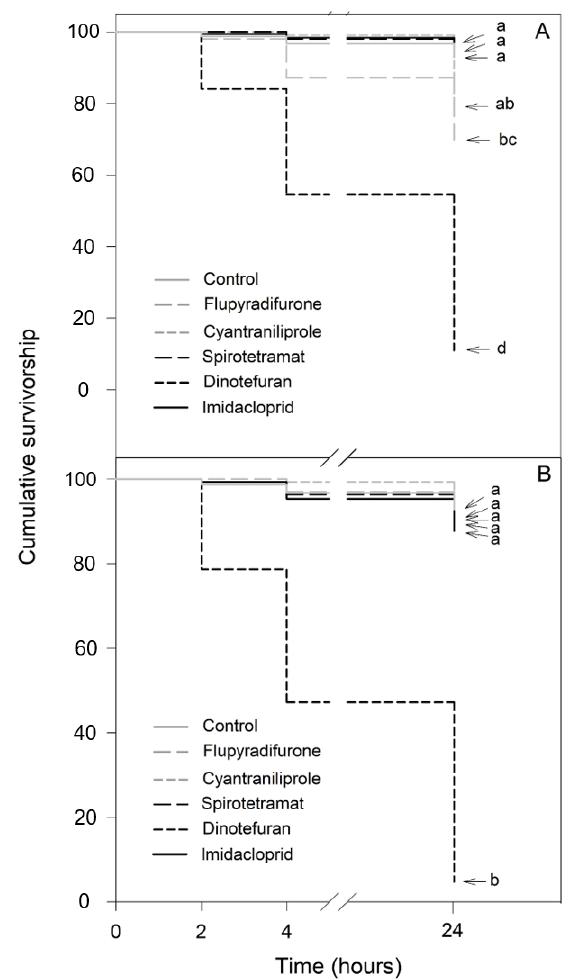
Figure 3. Kaplan–Meier survivorship curves of stingless bees orally exposed to 100-fold diluted commercial formulation of the selected insecticides: dinotefuran, 6 mg L −1 ; imidacloprid, 7 mg L −1 ; flupyradifurone, 6.8 mg L −1 ; spirotetramat, 3 mg L −1 ; and cyantraniliprole, 2 mg L −1 . The figure displays Nannotrigona perilampoides ( A ) and Frieseomelitta nigra ( B ). The estimated survival functions were compared with a nonparametric Log-Rank test (Holm–Sidak method). Significant differences ( p < 0.05) among insecticide treatments are indicated by different letters.